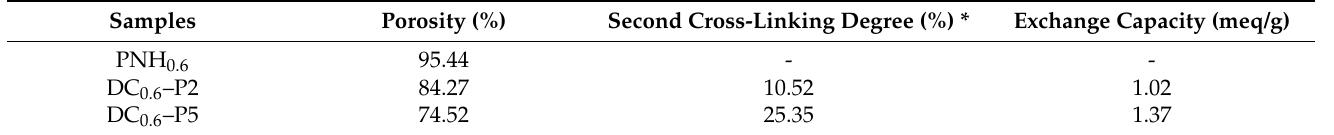
Table 2. The main characteristics of the most relevant DC hydrogels in comparison with conventional ones. Samples Porosity (%) Second Cross-Linking Degree (%) * Exchange Capacity (meq/g) PNH 0.6 95.44 - - DC 0.6